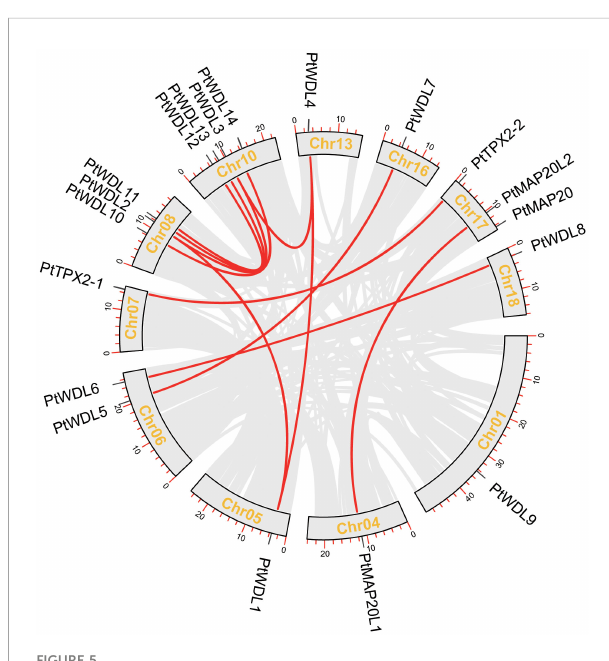
FIGURE 5 Relationship between different PtTPX2 genes in different chromosomes. Grey lines indicate all homologous blocks in the Populus trichocarpa genome, and the red lines indicate duplicated PtTPX2 gene